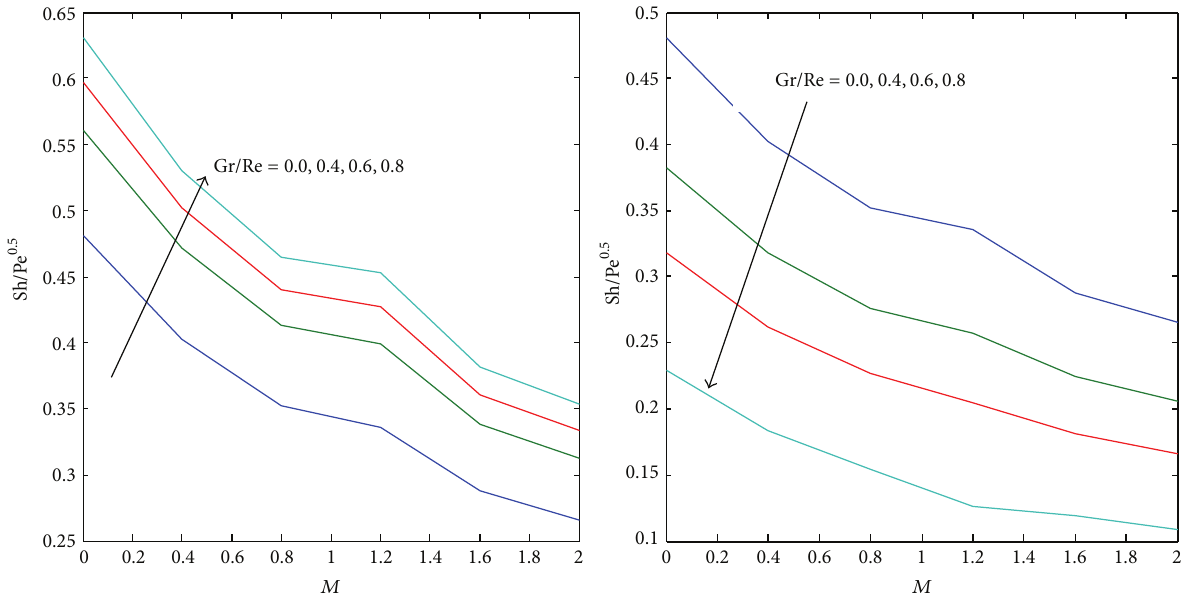
Figure 10: The Sherwood number varying with the melting parameter 𝑀 for aiding and opposing external flows and in the different mixed convection strength, 𝑁 = 0.5 , Df = 0.03 , Sr = 0.3 , and Le = 1.0 .